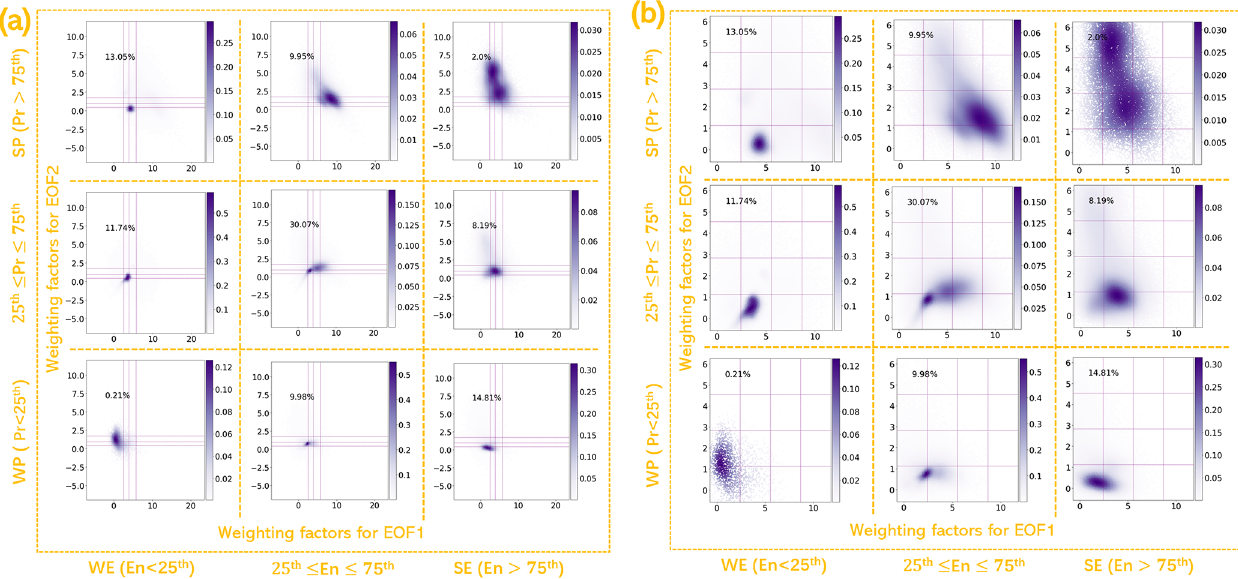
Figure 6. The scatterplots of weighting factors for EOF1 and EOF2 for different intensity levels of cloud-top entrainment and precipitation. The weak level, mid-level, and strong level of cloud-top entrainment is characterized by cloud-top entrainment rate below the 25th percentile, in between the 25th and 75th percentiles, and above the 75th percentile. Similarly, three levels of precipitation are characterized by the rainwater